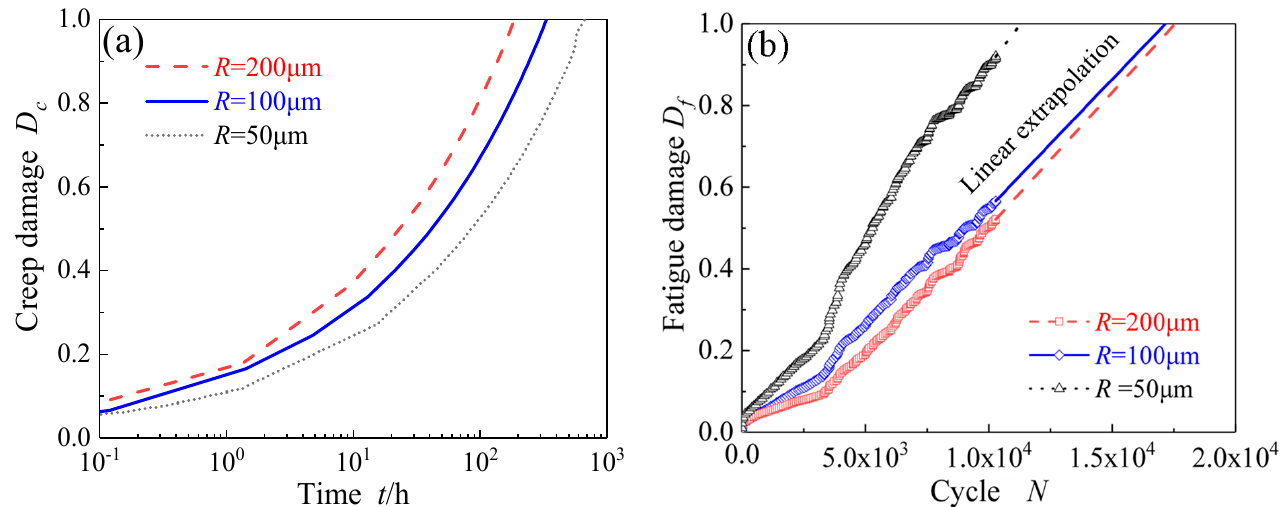
Figure 7. Evolution curves of ( a ) creep damage vs. time, and ( b ) fatigue damage vs. cycle of the hotspots in the specimens with different notch root radii.